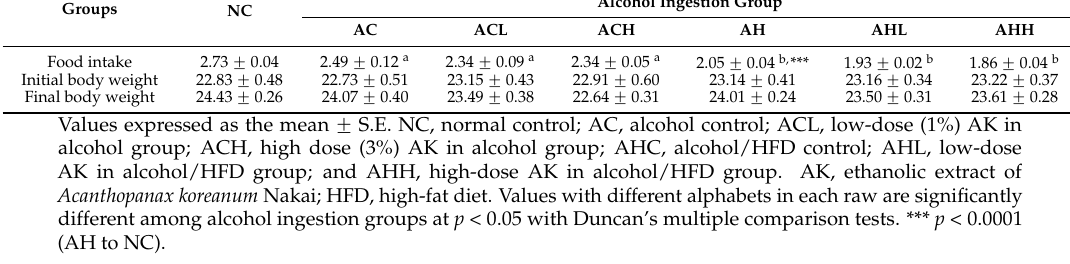
Table 1. Effects of AK on food intake and body weight of C57BL/6J mice fed with alcohol and HFD.